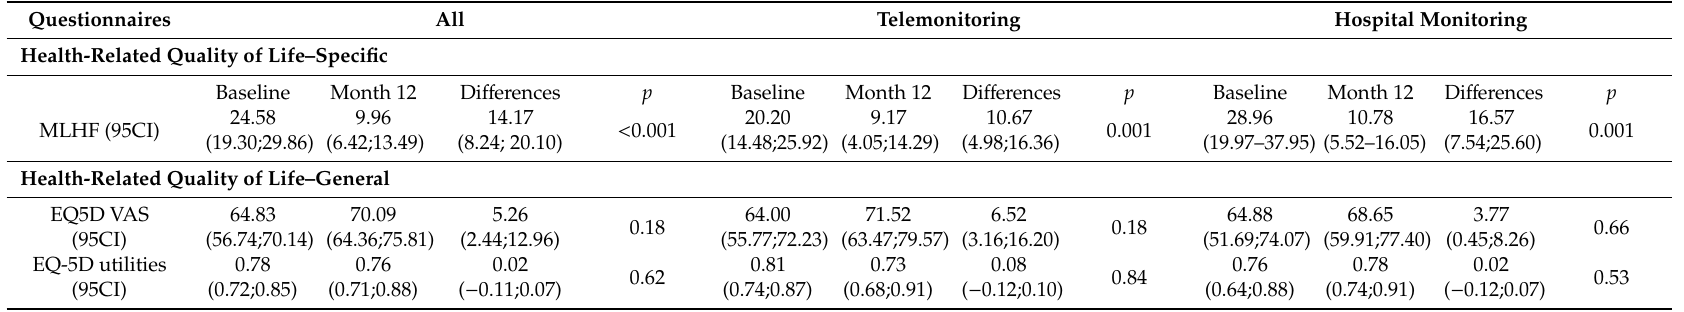
Table 3. Di ff erences in health-related quality of life at 12 months of follow-up. Questionnaires All